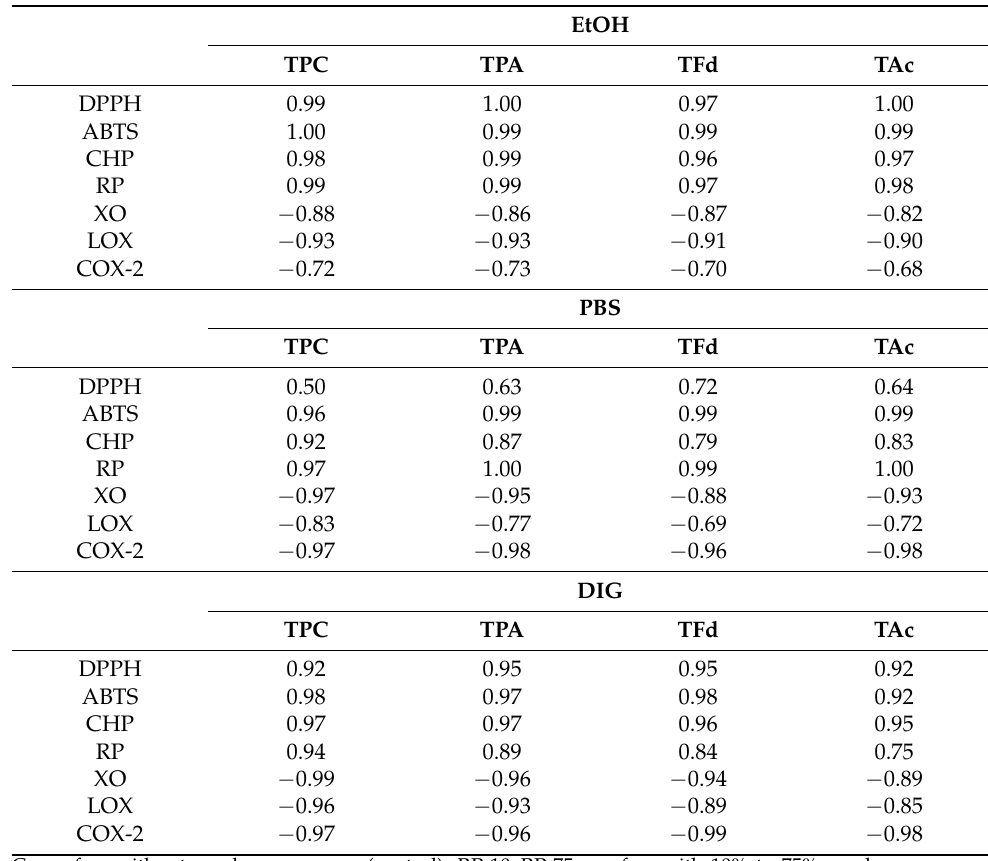
Table 5. Pearson correlation coefficient between values of polyphenol content and antioxidant or anti-inflammatory activity of different extracts from wafers fortified with freeze-dried raspberry pomace. EtOH TPC TPA TFd DPPH